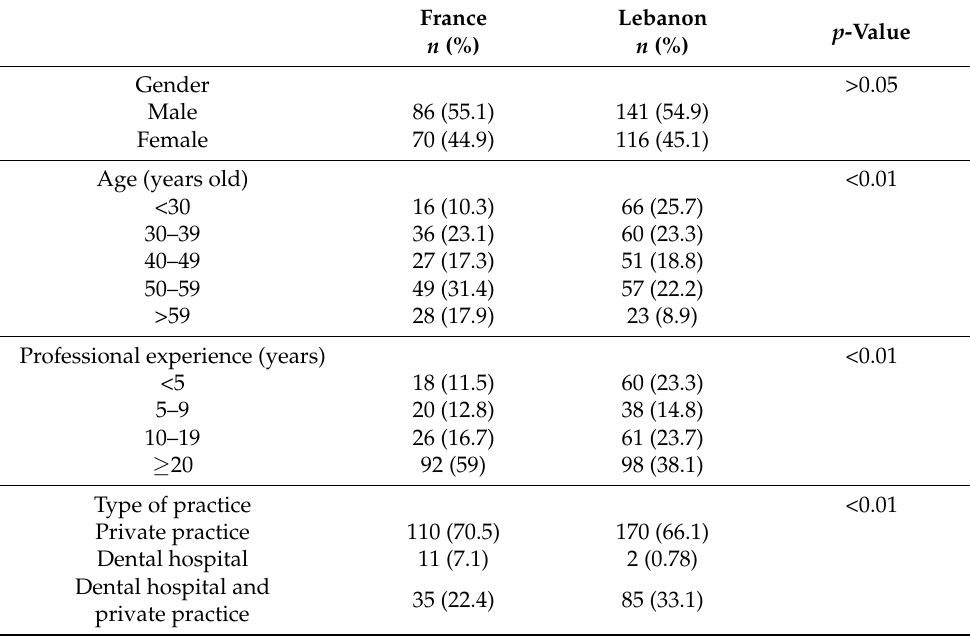
Table 1. Demographic characteristics of French dentists (FD) and Lebanese dentists (LD). p -Value corresponds to statistical significance between FD and